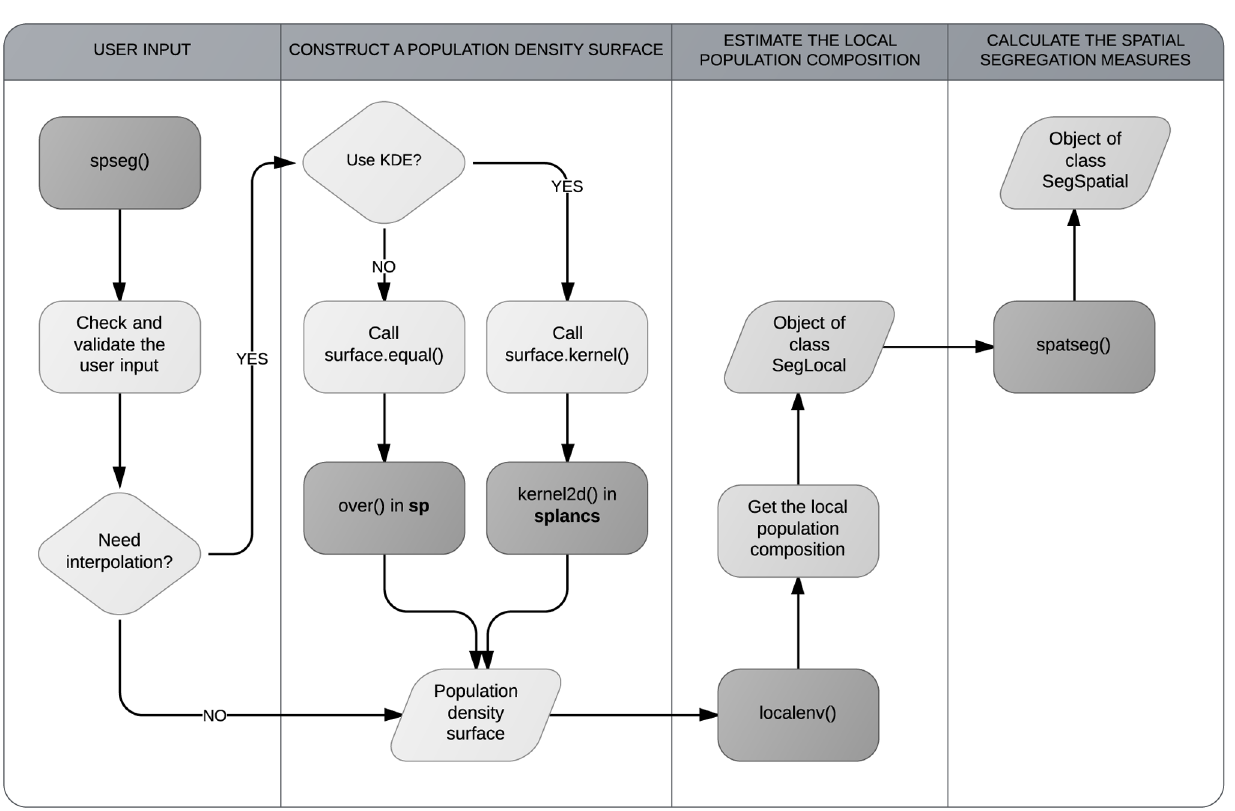
Figure 1. Computational flow of the spseg() function. It calls a series of subfunctions to calculate the spatial segregation measures. In this diagram, the curved-rectangles represent R functions and processes, the parallelograms refer to R objects, and the diamonds indicate the user options. Among the rectangles, only the shaded ones are user-level